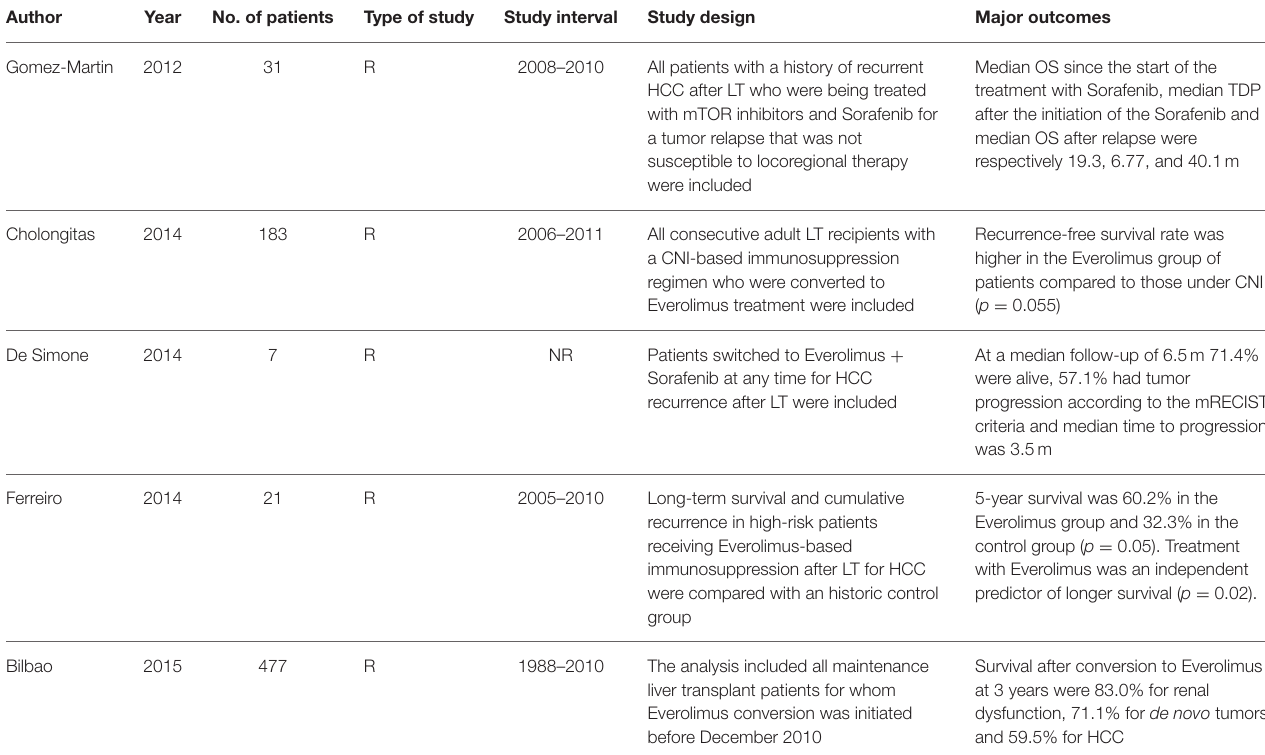
TABLE 1 | Outcomes of most relevant papers in literature (R, retrospective; OS, Overall Survival; TDP, time to disease progression; NR, not